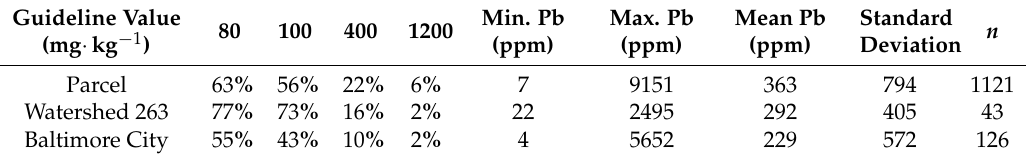
Watershed 263 Baltimore